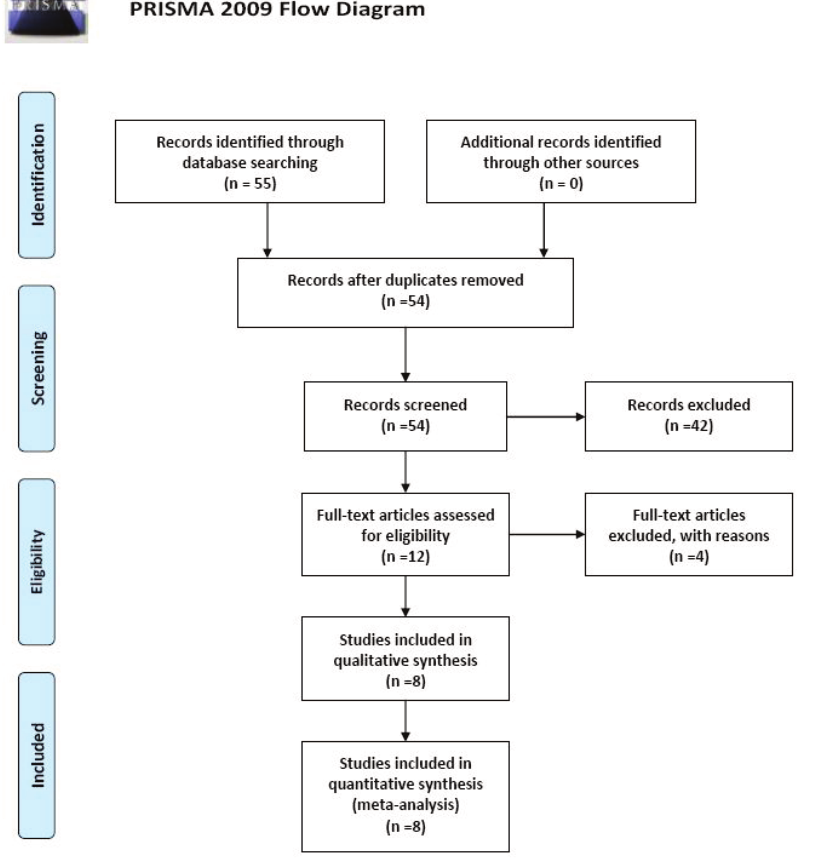
Figure 1: The paper searching flow